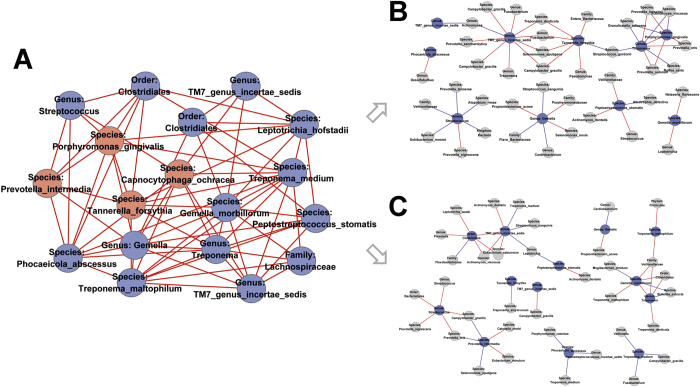
Co-occurring network modules in PM site and corresponding OTUs in HC and PI sites.Edges between each pair of OTUs indicate significant correlations (P < 0.01 by permutation test). Red and blue edges indicate positive and negative correlations, respectively. (A) Module in PM network consisted of OTUs with at least five degrees. Periodontal pathogens were marked red. (B, C) Corresponding OTUs did not cluster into pairwise modules in HC and PI sites.